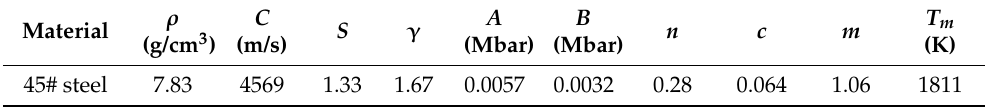
Table 4. The material parameters of the